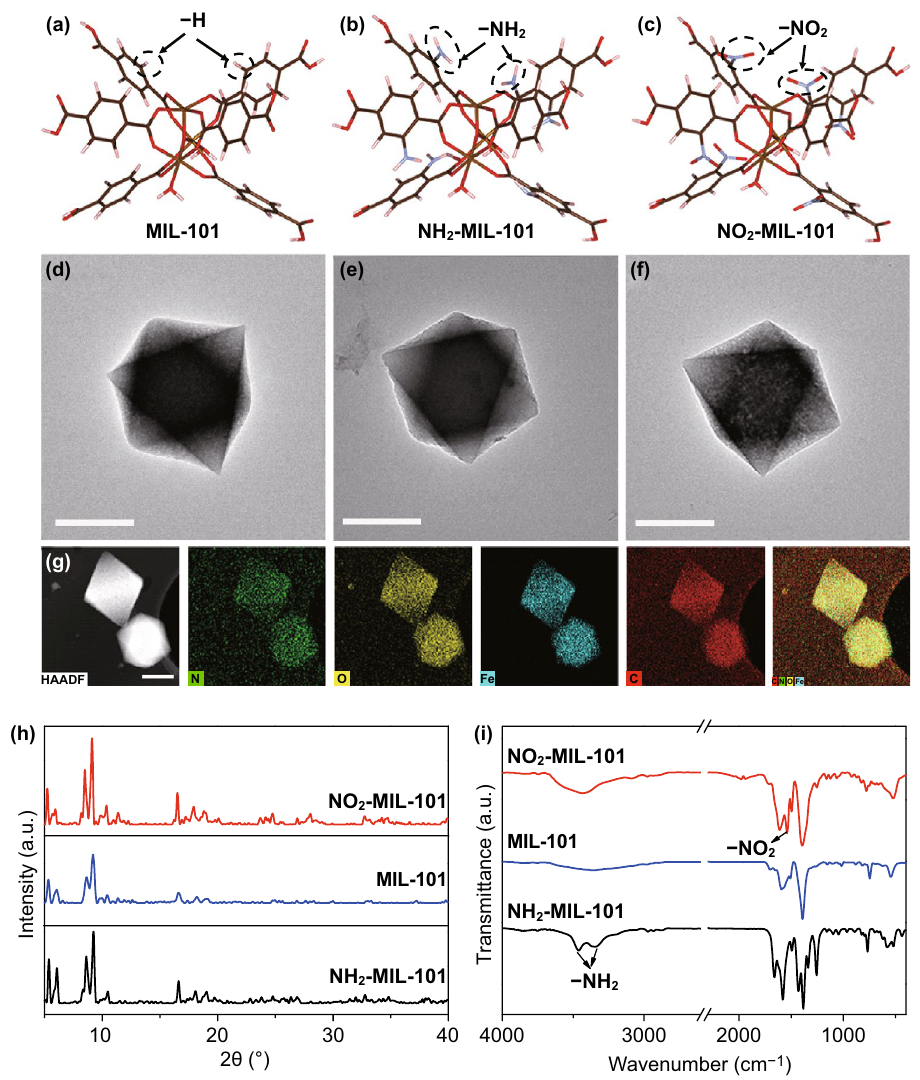
Fig. 1 Structures of a MIL-101, b NH 2 -MIL-101, and c NO 2 -MIL-101 (Fe: yellow, C: brown, O: red, H: pink, N: purple). TEM images of d MIL-101, e NH 2 -MIL-101, and f NO 2 -MIL-101. g HAADF-STEM image and STEM-EDS mappings of NO 2 -MIL-101, scale bar: 500 nm. h XRD patterns and i FT-IR spectra of MIL-101, NH 2 -MIL-101 and NO 2 -MIL-101. (Color figure